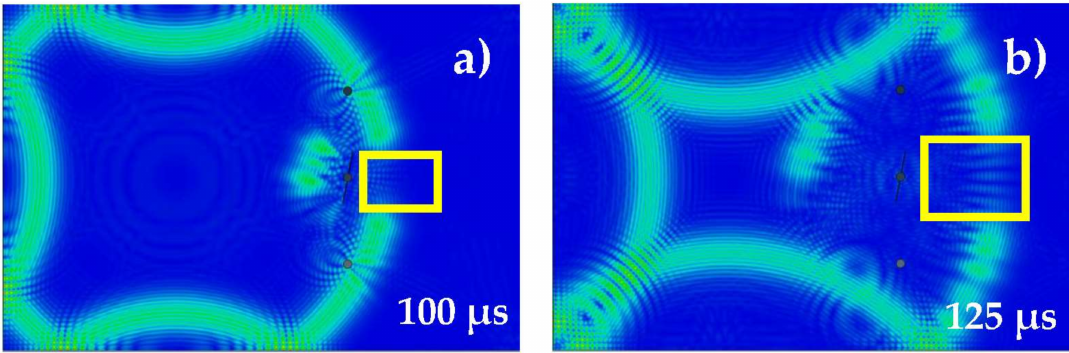
Figure 10. Lamb wave propagation at ( a ) t = 100 and ( b ) 125 µ s in Al 7075